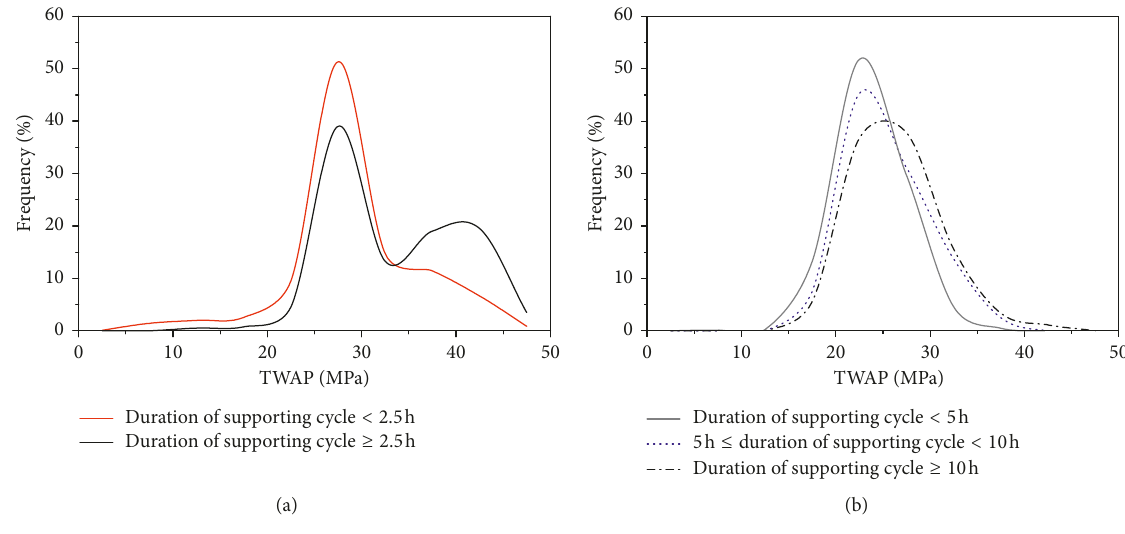
Figure 8: Frequency distribution of TWAP in longwall panels with strong roof (a) and medium-weak roof